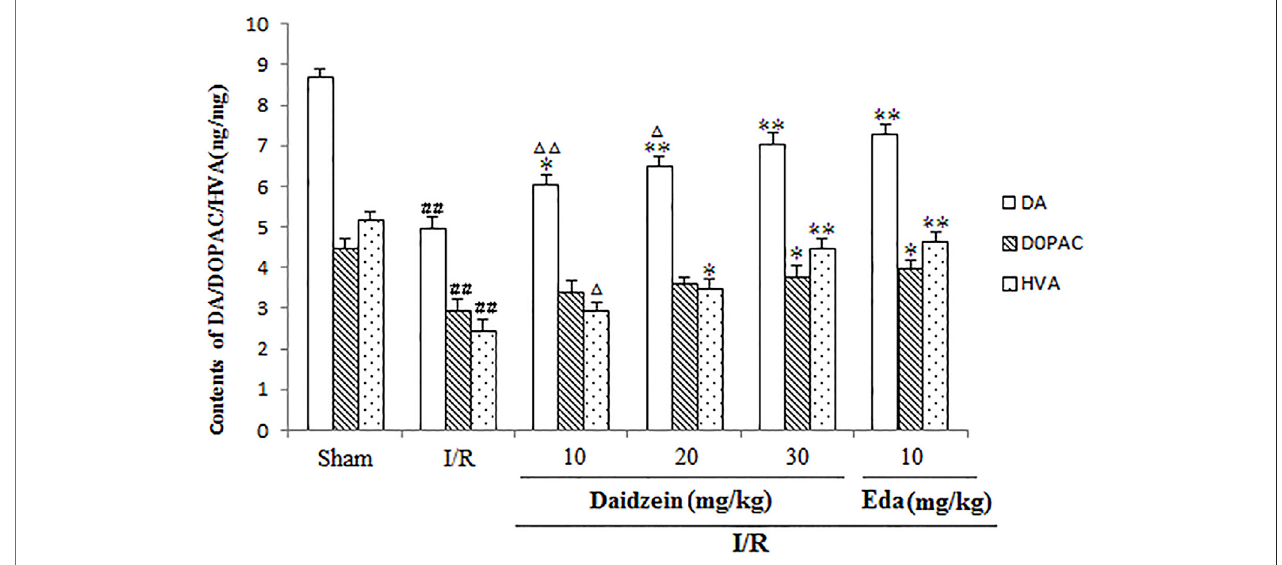
FIGURE 5 | Effects exerted by daidzein on homovanillic acid (HVA), 3, 4-dihydroxyphenylacetic acid (DOPAC), and dopamine (DA) within the striatum prior to I/R. Values have the expression to be means ± standard errors of the means (SEMs; n (cid:2) 6). ## p < 0.01, in contrast to the Sham group; * p < 0.05, ** p < 0.01, in comparison with the I/R group; △ p < 0.05, △△ p < 0.01, compared with the Eda